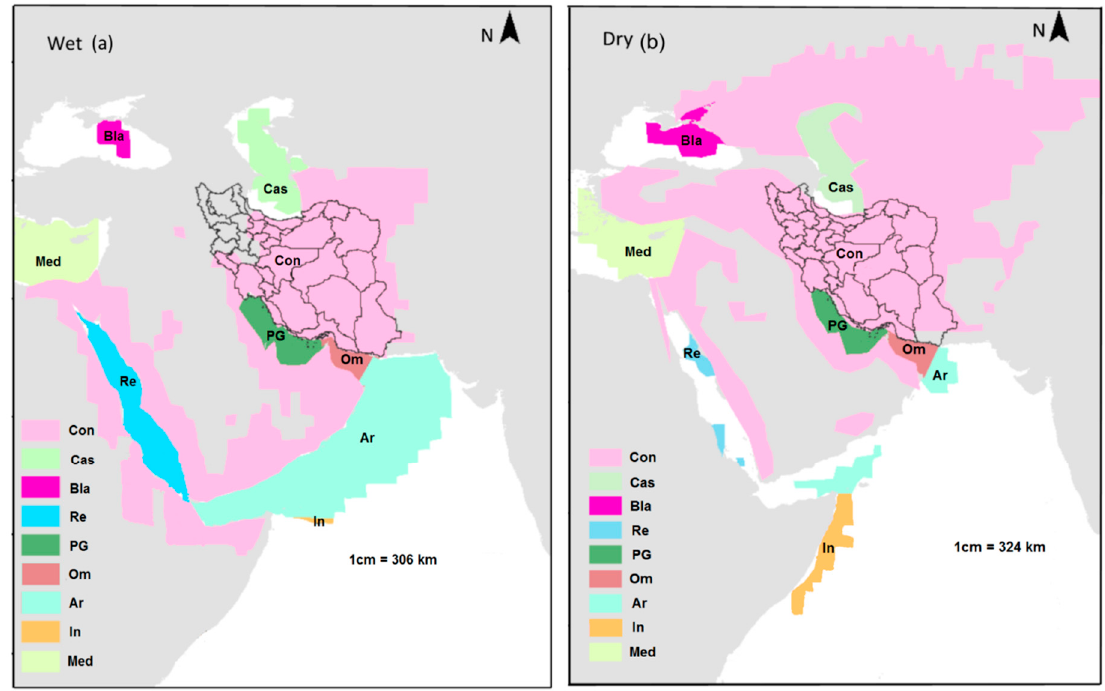
Figure 7. The spatial distribution of continental and oceanic moisture sources (E-P) > 0 for Iran in the wet ( a ) and dry ( b ) seasons. Con stands for Continental, Cas stands for the Caspian Sea, Bla stands for the Black Sea, Re stands for th Red Sea, PG stands for the Persian Gulf, Om stands for the Oman Sea, Ar stands for the Arabian Sea, In stands for the Indian Ocean, and Med stands for the Mediterranean Sea. Table 1. The moisture uptake percentage from various oceanic and continental sources for the Shiraz and Mashhad boxes during the wet and dry season from 1981 to 2015.